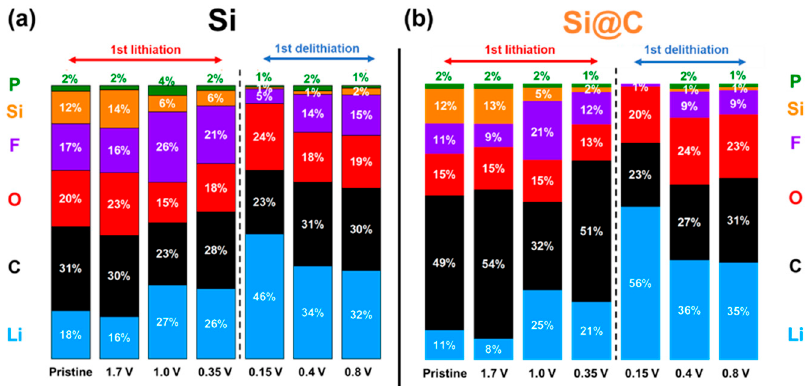
Figure 10. Quantification of each element analyzed for Si ( a ) and Si@C ( b ) materials during 1st cycle.